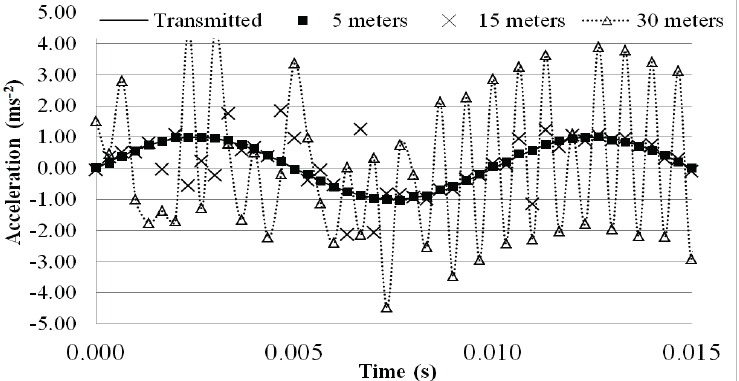
Figure 12. Time histories of wirelessly transmitted signal